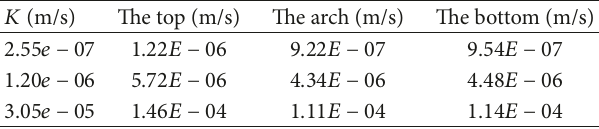
Table 4: The relationship between infiltration rate and the perme- ability coefficient of surrounding rock when grouting ring is 5m.